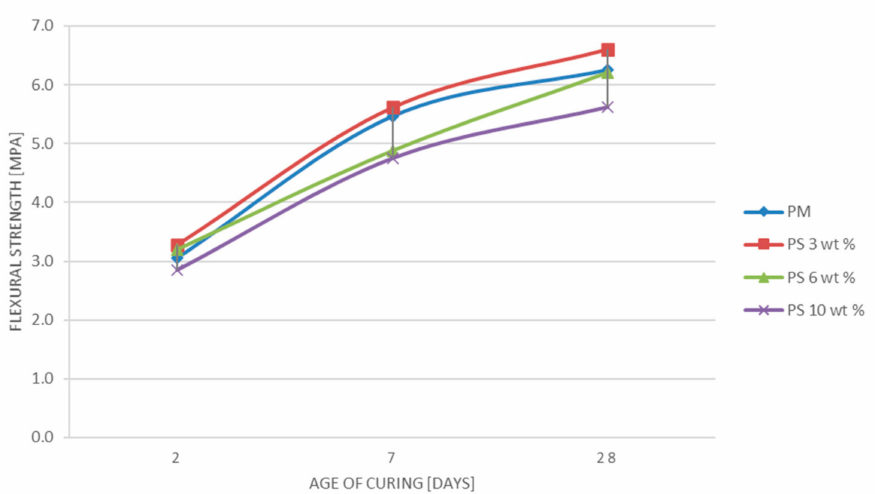
Figure 5. The diagrams of flexural strength results for samples with hydrogen plasma vitrified fiberglass (PS 3 wt %, PS 6 wt %, and PS 10 wt %) and the control samples (PM).